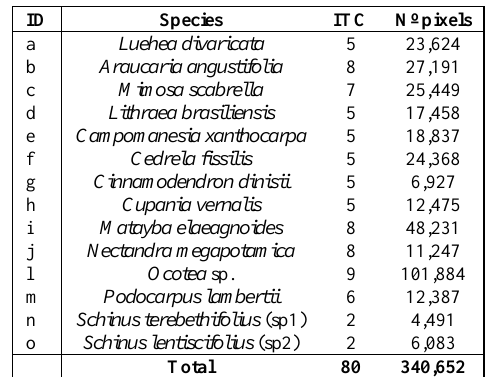
Table 1. Description of tree species, number of individual tree crowns (ITC) and pixel samples used in this study.